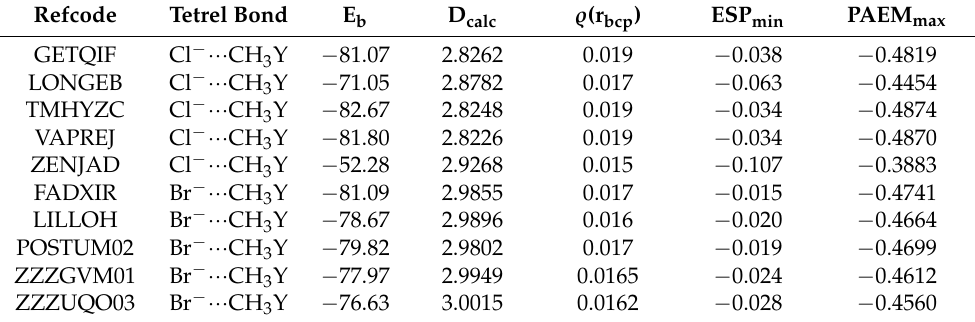
Table 2. Calculated binding energy E b (kcal/mol), bond lengths D calc (Å), electron density (cid:36) (r bcp )